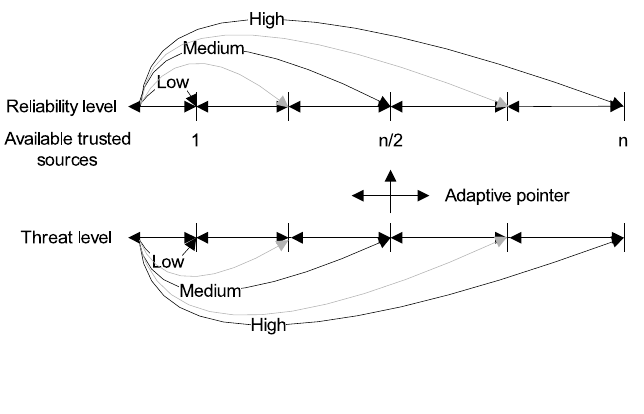
Figure 2. Intrusion-aware reliability mode